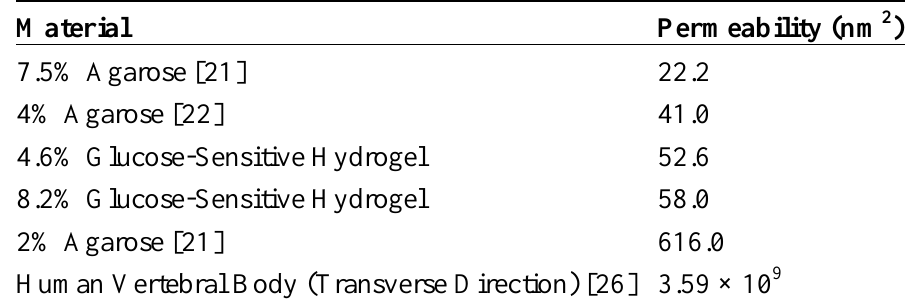
Table 3. Comparison of published permeability values with the permeability of hydrogels exposed to 100 and 300 mg/dL glucose solutions, which resulted in 4.6% and 8.2% glucose-sensitive hydrogels,